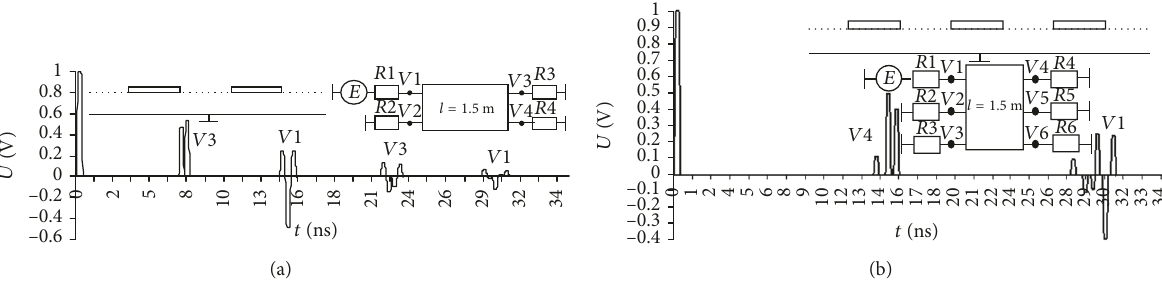
Figure 2: Voltage waveforms at the input and output of the microstrip line active conductor when (a) 𝑁 = 2 and (b) 𝑁 = 3 .